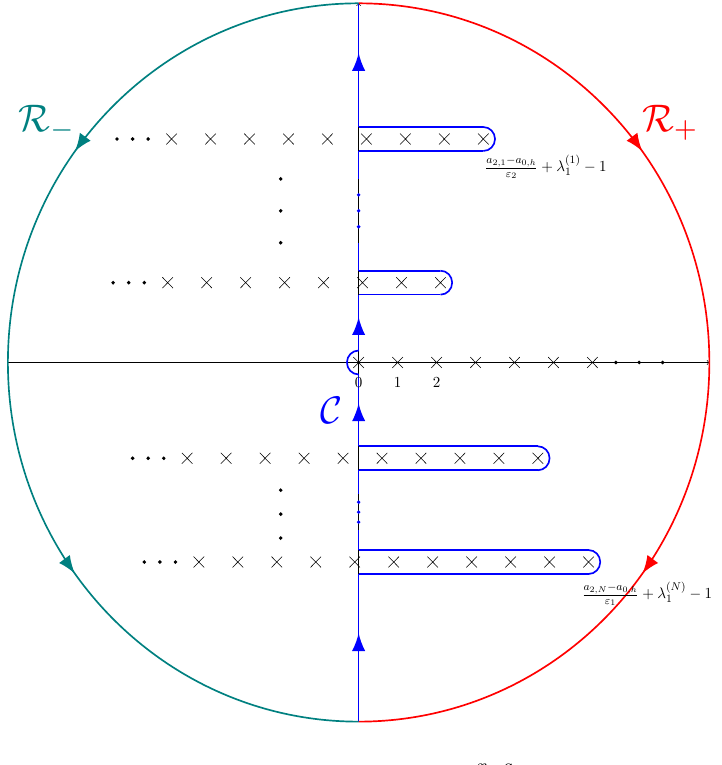
Figure 1 . The contour C on the x − a 0 ,h